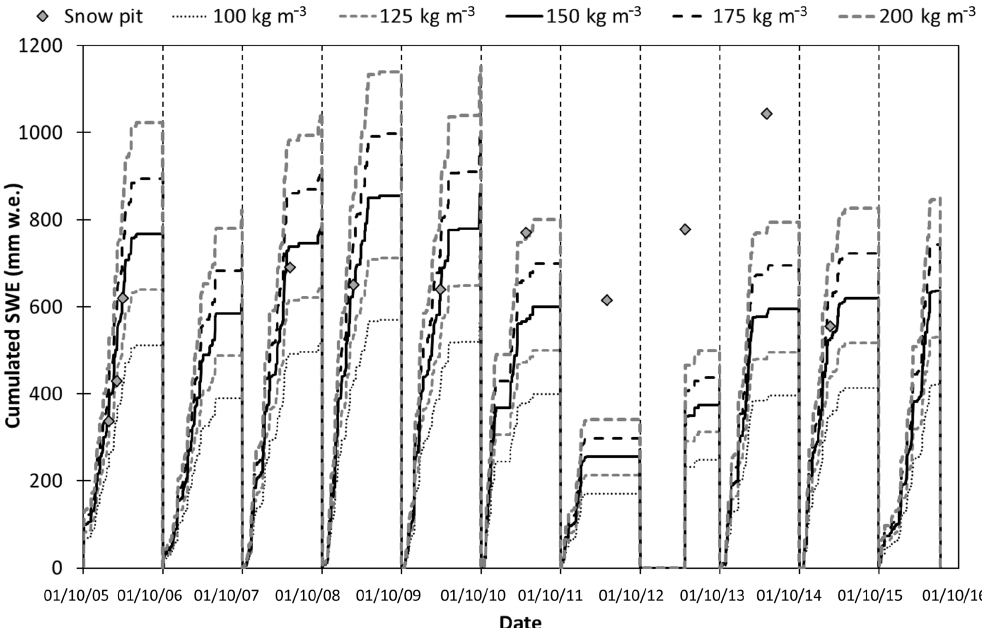
Figure 6. Comparison among daily SWE values derived from snow depth data acquired by SR50 sonic ranger (applying different values of new snow density) and SWE values measured by snow pits from 2005 to 2016. The dates shown are dd/mm/yy.